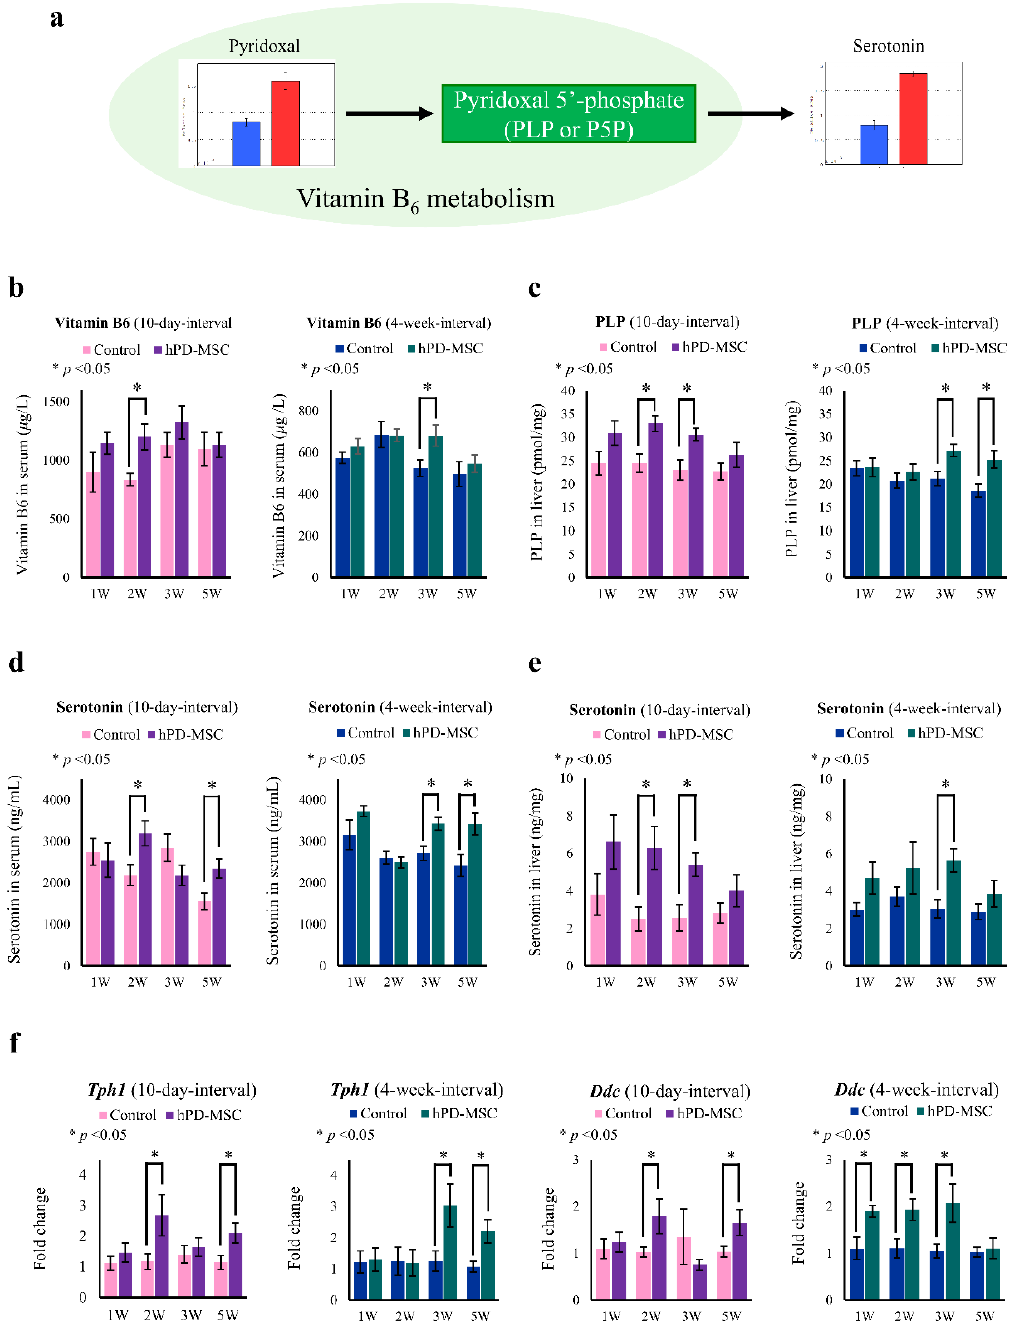
Figure 3. Multiple-injection hPD-MSC therapy induces vitamin B6 metabolism and serotonin synthesis with aging. ( a ) Schematic diagram representing the regulatory pathway between vitamin B6 and serotonin metabolism by CE-TOF/MS analysis. The relative quantities of pyridoxal and serotonin in serum by metabolome analysis are shown as bar graphs. Blue bar, control group; red bar, multiple-injection therapy group. ( b – e ) The concentrations of standard metabolites involved in vitamin B6 metabolism and serotonin. Levels of pyridoxal ( b ), PLP ( c ), and serotonin in serum ( d ) and levels of serotonin in the liver ( e ) as determined by ELISA at various time points after multiple injections of hPD-MSC therapy. Pyridoxal, PLP, and serotonin showed higher abundance after multiple-injection hPD-MSC therapy at 10-day intervals or 4-week intervals. Data are presented as the mean ± SEM. The asterisk represents statistical significance at p < 0.05. Control, PBS-injected group; hPD-MSCs, multiple-injection hPD-MSC therapy group. ( f ) Changes in the expression of genes related to the production of serotonin were evaluated by qRT – PCR in the liver after multiple injections of hPD-MSC therapy.